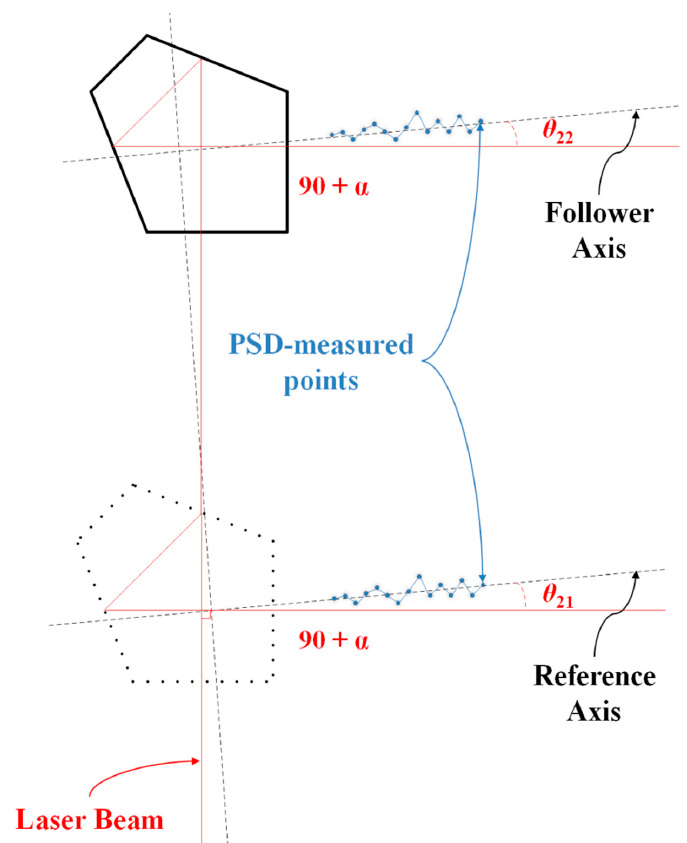
Figure 8. Beam path of parallelism measurement.